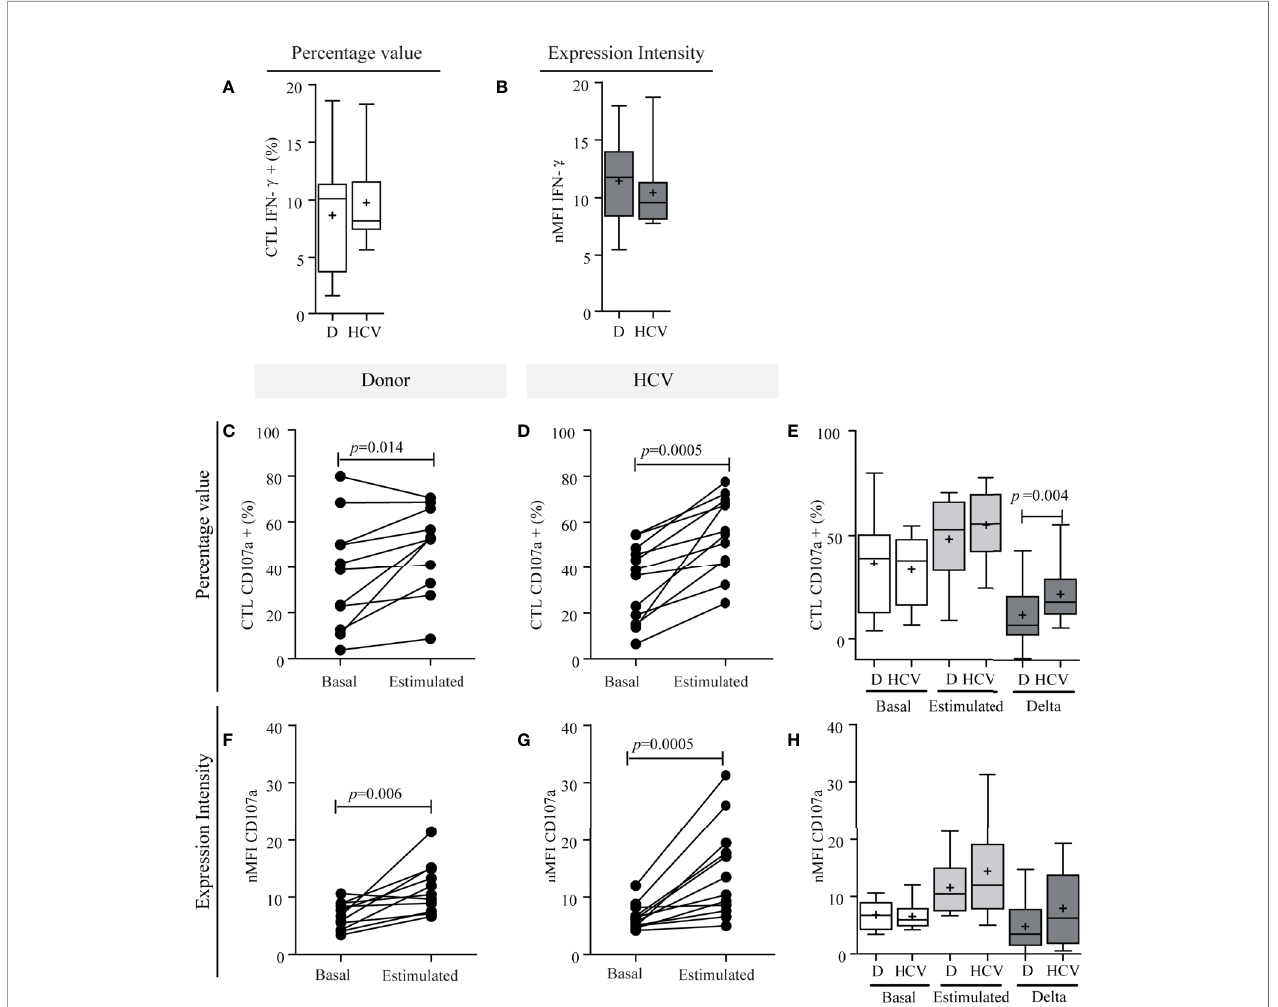
FIGURE 6 | Functional characterization of CTLs. IFN- g production capacity (A, B) and degranulation activity of CTLs (C – H ). IFN- g production of CTLs in patients and donors (A, B) . Percentage values (A) and intensity of expression (B) . CD107a expression in CTLs in percentage values (C – E) and in intensity of expression (F – H) . Comparison of the response between basal conditions and before the stimulus per case in donors (C, F) and in patients (D, G) . Comparison of CD107a basal expression in CTLs, stimulated and magnitude of response (delta) between donor vs. patient (E, H) . Results are expressed as percentage values (C – E) and intensity of expression (F – H) . D, donor. When it corresponds, the results are depicted in box plots. Horizontal lines within boxes indicate medians. Horizontal lines outside the boxes represent the 5 and 95 percentiles. Mean is indicated as +. Student ’ s t-test (A, E) , Wilcoxon test (C, D, G) , paired t-test (F) and Mann – Whitney U test (B, H) were used to compare different data sets. The analysis of absolute values displayed similar results to the percentage values, but it is not shown to simplify their